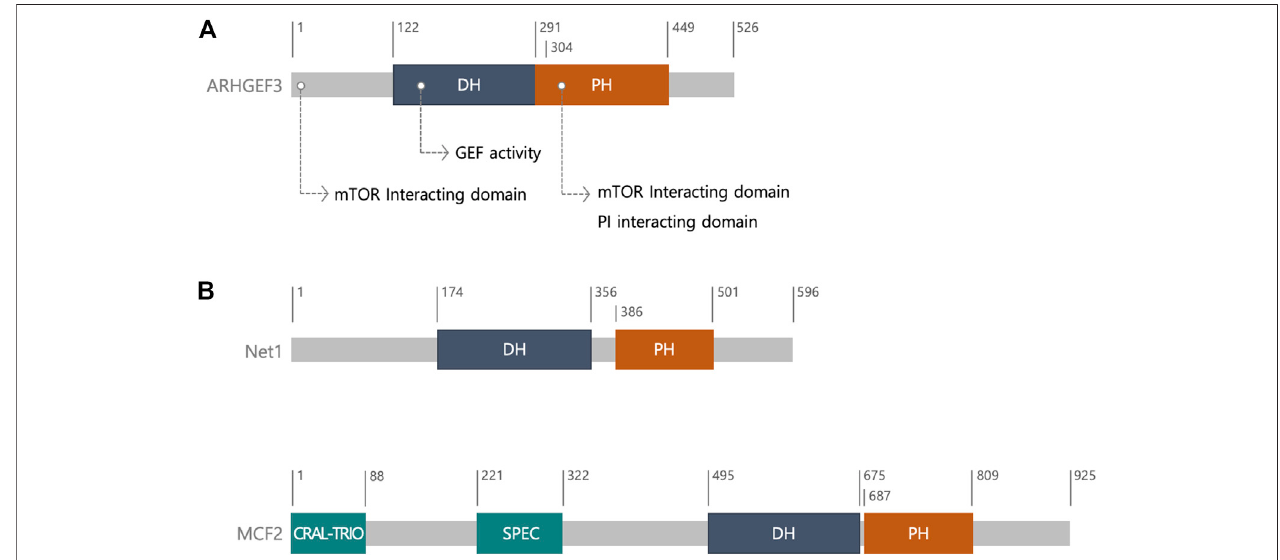
FIGURE 1 | The structure of ARHGEF3. (A) Schematic diagram and ARHGEF3 with its function. (B) Schematic diagram of neuroepithelial cell transforming gene 1 (Net1)andMCF2.ARHGEF3 ’ sDH-PHdomainshaveasequencesimilarityofover69percenttothatofNet1.MCF2isoneofthediffuseB-celllymphoma(Dbl)family.The CRAL-TRIO domain is involved in interaction with inositol phospholipids and SPEC domain promotes the interaction with membrane proteins. Abbreviation; the diffuse B-celllymphoma(Dbl)homology(DH);pleckstrinhomology(PH);cellularretinaldehyde-bindingprotein(CRALBP)andTRIOguanineexchangefactor(CRAL-TRIO); spectrin